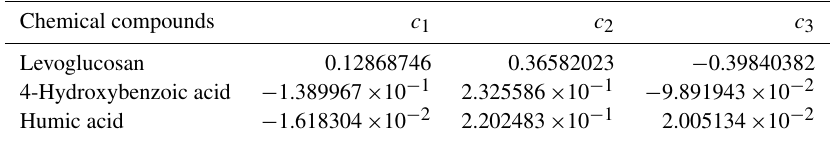
Table 3. Coefficients ( c 1 , c 2 , c 3 ) of the fitted growth factor parameterization (Eq. 5) as